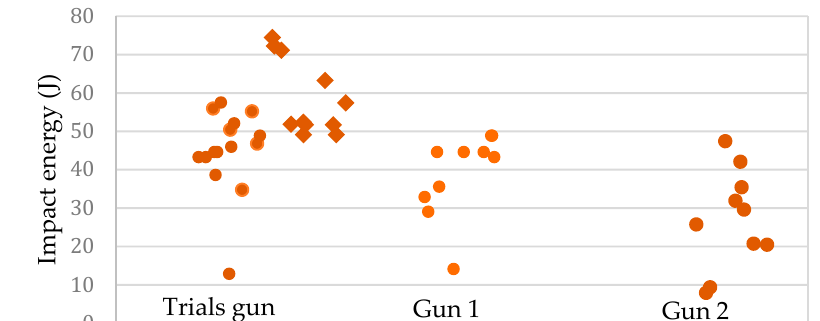
Figure 14. Impact energy for three Accles and Shelvoke Small Animal tools using brown 1.00 grain cartridges. Trial gun energies shown with recuperating sleeves cold (round markers) and warm (diamond markers).